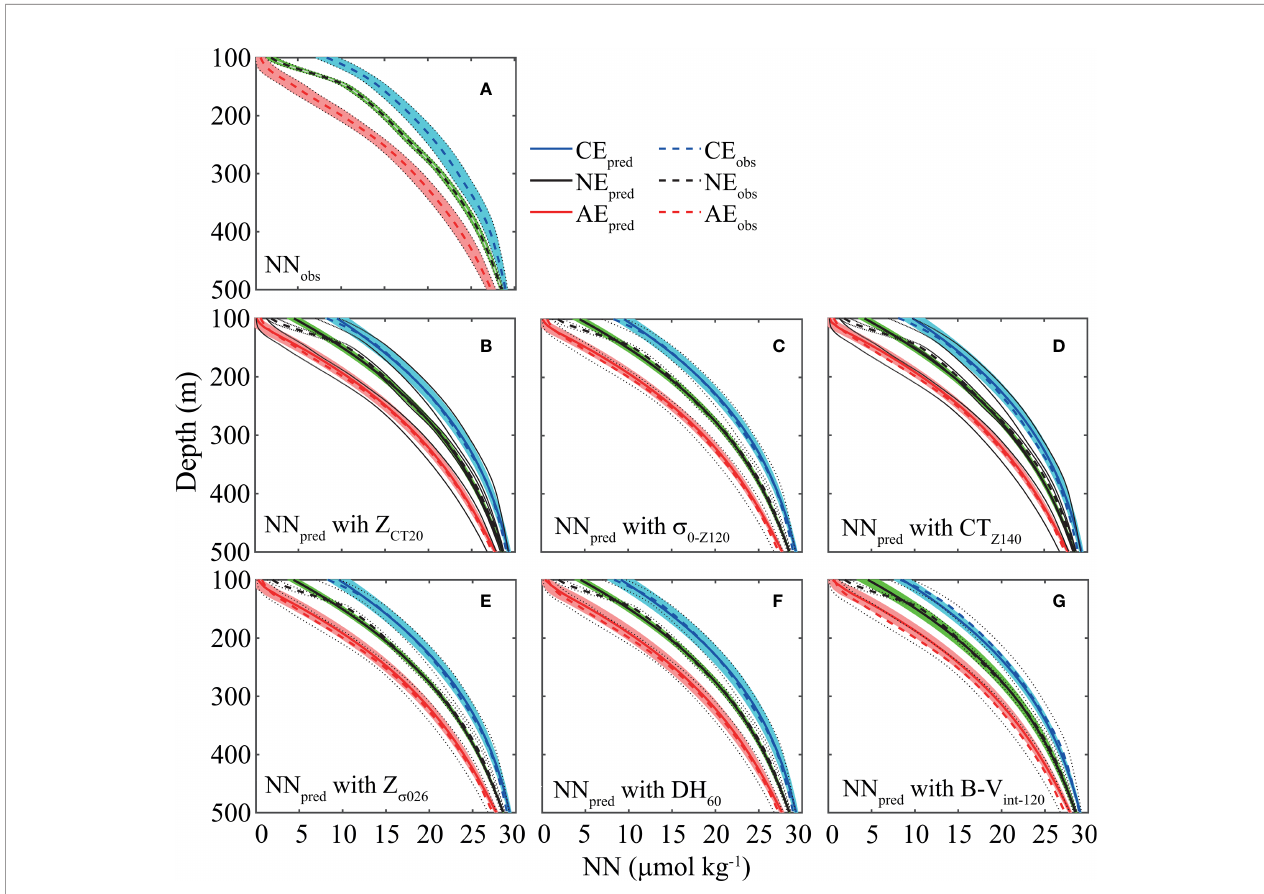
FIGURE 8 | Average of the nitrate + nitrite (NN, µmol kg -1 ) depth pro fi les with 95% con fi dence intervals (CIs) for cyclonic (CE; blue-cyan), no eddy (NE; black-green), and anticyclonic (AE; red-pink) groups without Poseidon stations. (A) NN observed and predicted (µmol kg -1 ) with cubic polynomial fi ts for (B) the depth of the 20°C isotherm (Z CT20 , m), (C) potential density anomaly at 120 m ( s 0-Z120 , kg m -3 ), (D) Conservative Temperature at 140 m (CT Z140 , °C), (E) depth of the 26 kg m -3 isopycnal (Z s 026 , m), (F) integrated dynamic height between 1000 – 60 m (DH 60 , m 2 s -2 ), and (G) the integrated Brunt-Väisälä frequency between 15 – 120 m (B-V int- -1 ). The blue, black, and red solid (dashed) lines correspond to the predicted (observed) average NN for the CE, NE, and AE groups, respectively. Black 120 , m s dotted lines correspond to ± 1 standard deviation around the observed mean of NN (Panel A ). Some (~3%) predicted NN values for the AE group were negative around 100 – 125 m (mean ~107 m) and were replaced with 0 µmol kg -1